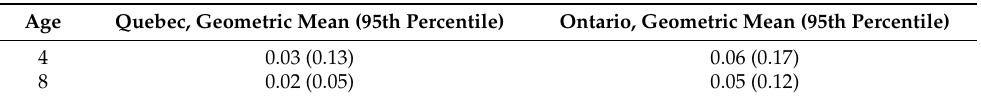
Table 4. Absorbed fluoride doses (mg/kg/d) modeled with CHMS biomonitoring data from Quebec and Ontario.